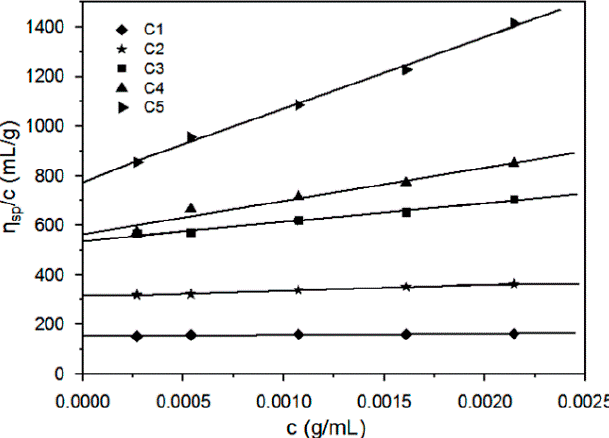
Figure 1. Condensed viscosity ( η sp / c ) and concentration of five cellulose samples in the THDS. Table 2. The intrinsic viscosity ([ η ]) and the K 1 values of cellulose solution in THDS at 25 °C. Samples Parameters C1 C2 C3